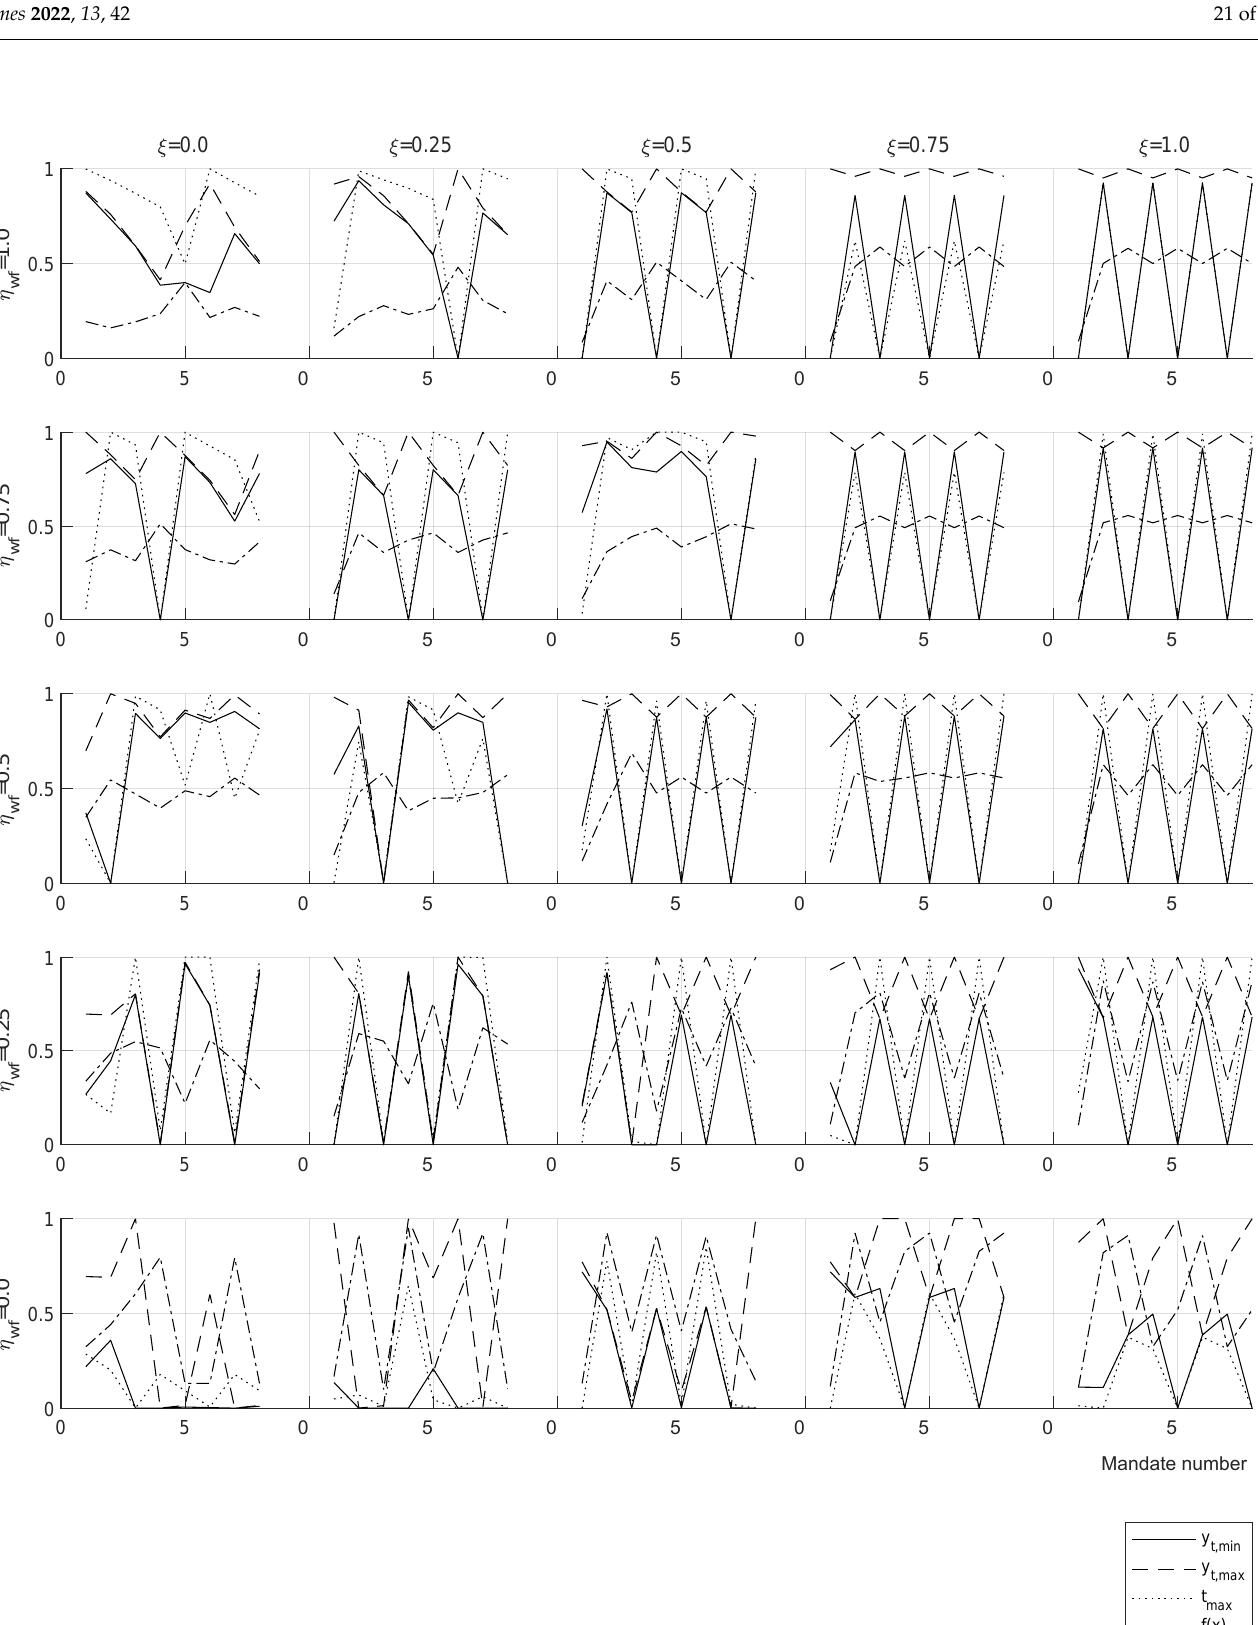
Figure A6. Tax policy evolution under yardstick vote during eight mandates for a series of welfare efficiency values η wf and tax disincentive ξ . Per citizen criterion. Mandate length: 4 years. Voters improvement demand